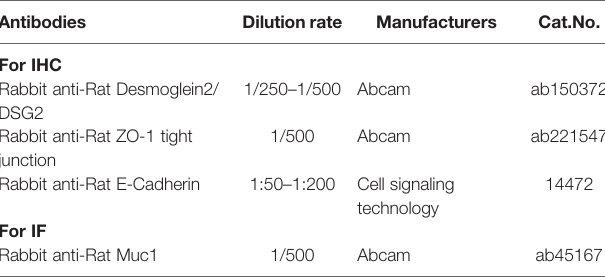
TABLE 2 | Antibodies and other